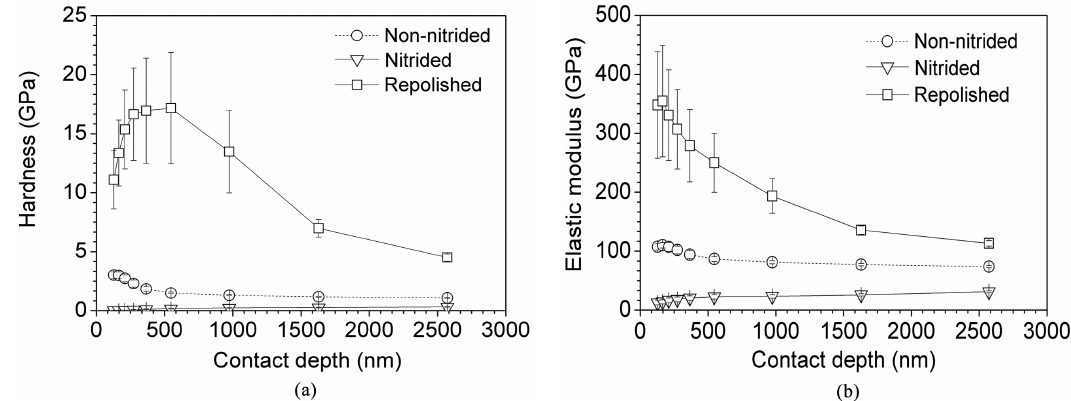
Figure 3. (a) Nanohardness; and (b) Elastic modulus results as a function of the indentation (penetration) depth, for the studied Table 1. Average (+ standard deviation) values for the surface roughness parameters Sa , Sz , Sp , Sv , Sds, and Ssk, obtained at non-nitrided, nitrided, and repolished-after-nitrided surfaces. Condition